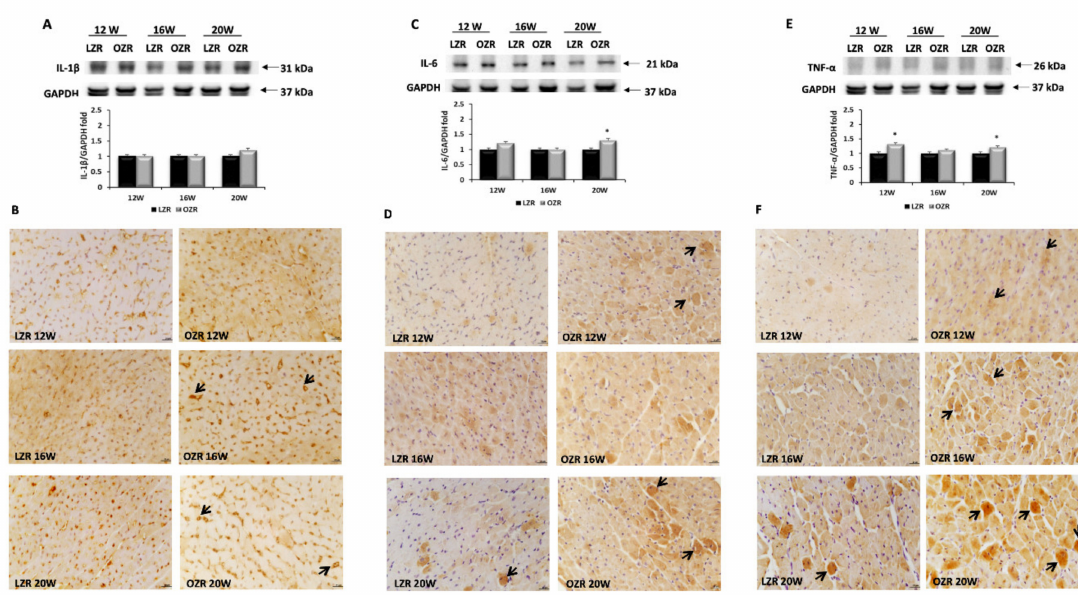
Figure 6. Inflammation. Lysates of heart from lean Zucker rats (LZR) and obese Zucker rats (OZR) at the age of 12, 16, and 20 weeks were immunoblotted using specific anti: ( A ) interleukin 1 beta (IL-1 β ); ( C ) interleukin 6 (IL-6); ( E ) tumor necrosis factor α (TNF- α ). Values indicate the densitometric analysis using LZR rats as control. GAPDH levels were used as loading control. Data are mean ± S.E.M. * p < 0.05 vs. age matched LZR. Blots are representative of one of three separate experiments. TNF- α membrane was stripped and incubated with anti-IL-1 β antibody. Control images were reused for illustrative purposes. Sections of the heart of 12, 16, and 20 weeks old LZR and OZR processed for the immunohistochemistry of ( B ) IL-1 β ; ( D ) IL-6; ( F ) TNF- α , at the magnification 40 × . The cardiomyocytes that are more immunoreactive are indicated with the arrows. Calibration bar 25 µ